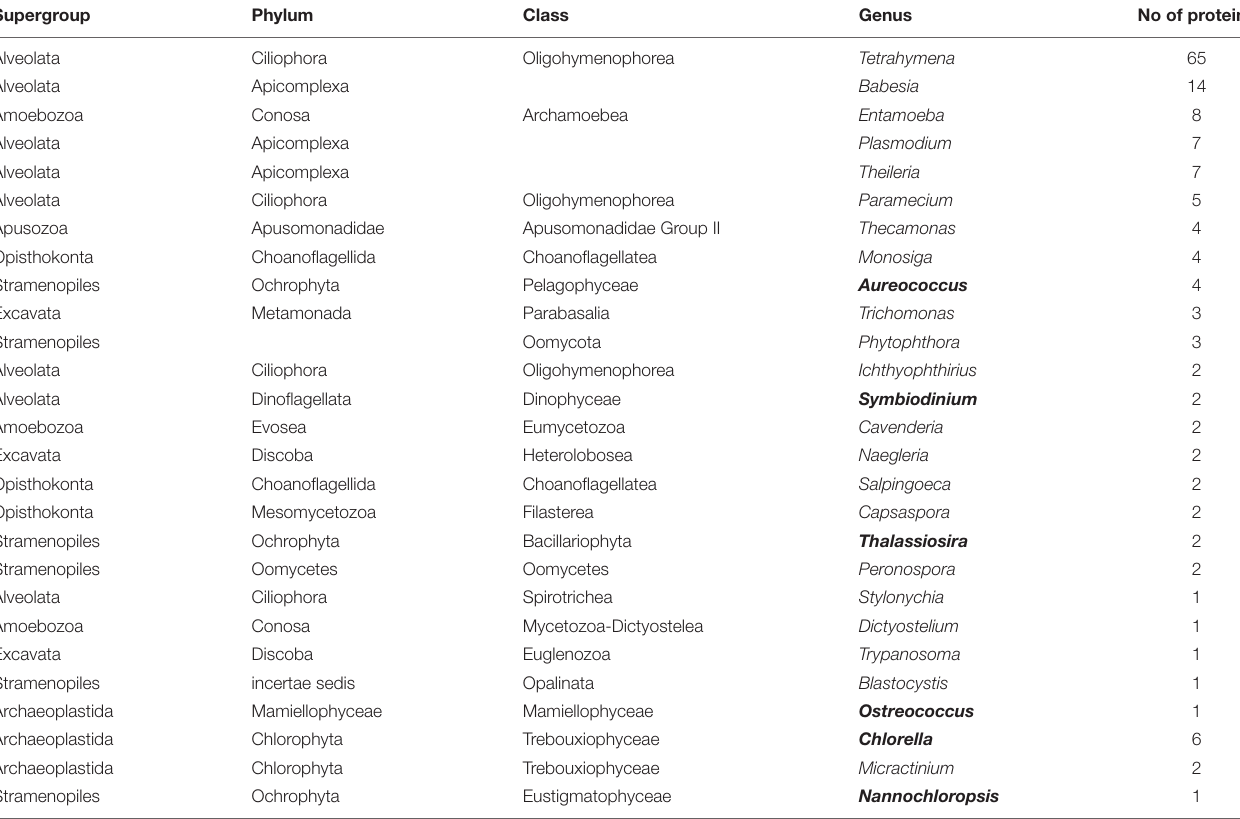
TABLE 1 | Genera of microbial eukaryotes in which metallothioneins have been predicted and eventually described 12